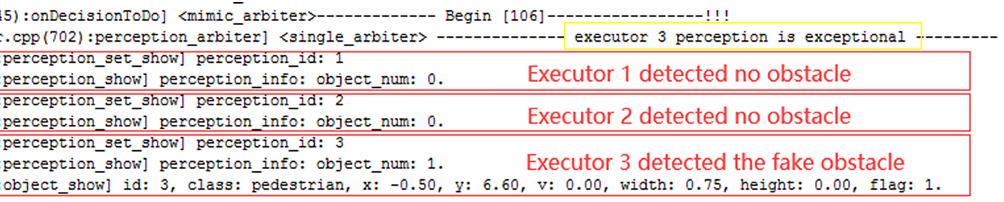
Figure 9. The arbitration process of DHR under cyberattack (one fake